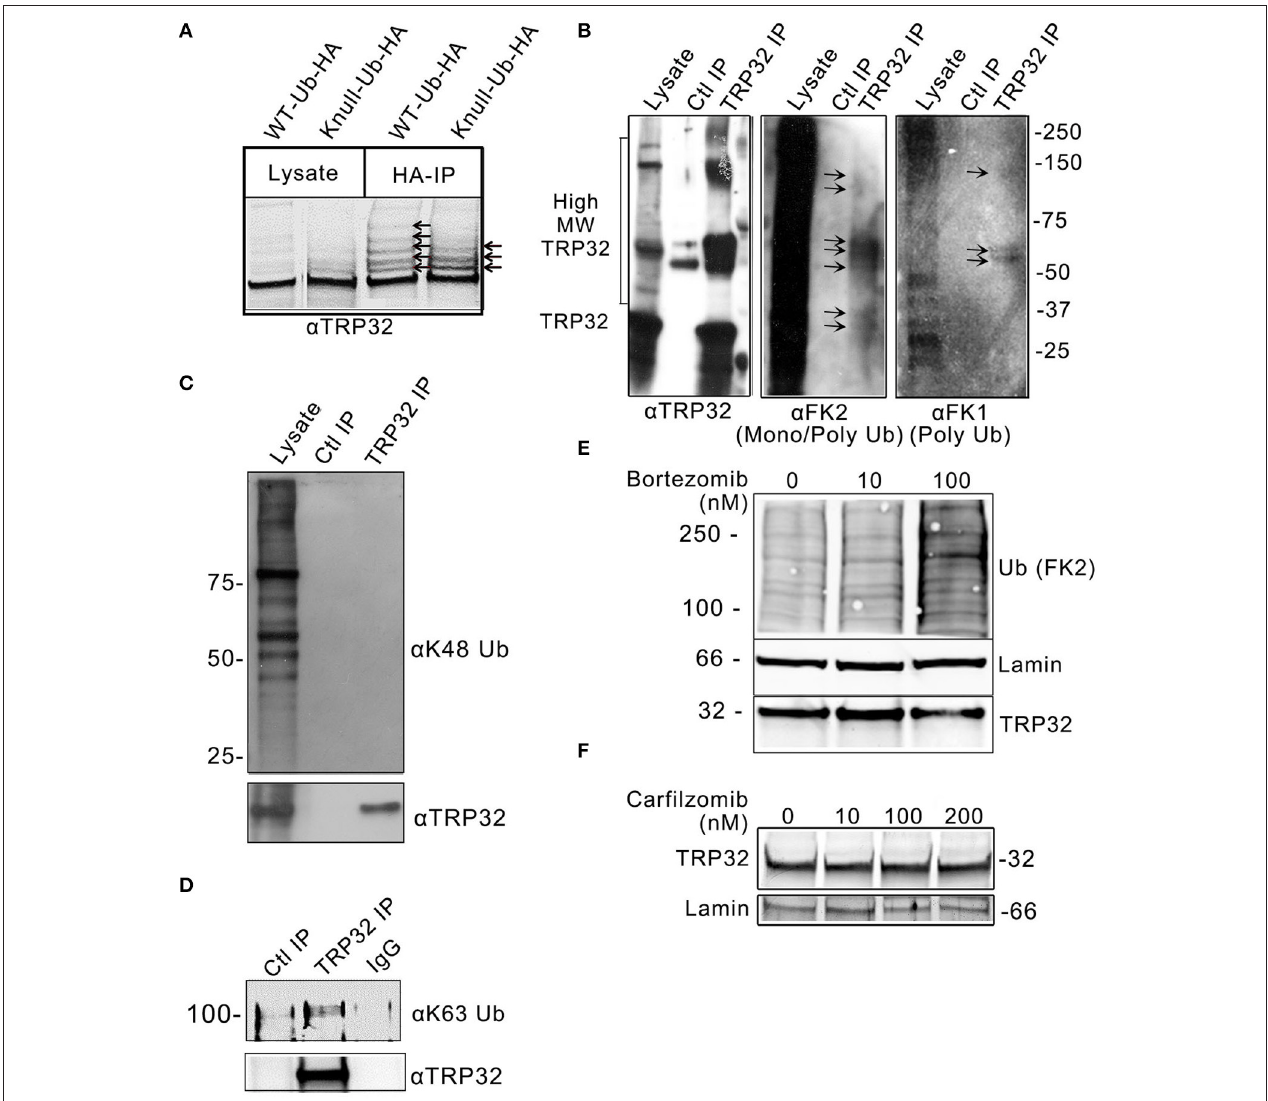
FIGURE 2 | E. chaffeensis TRP32 is mono and polyubiquitinated, but is not degraded by the proteasome. (A) GFP-tagged TRP32 was cotransfected into HeLa cells with HA-tagged WT and K-null Ub constructs. HA-immunoprecipitation was performed and the resulting eluate was probed with anti-TRP32 specific antibody by immunoblot. Multiple higher molecular weight bands indicative of ubiquitinated species of TRP32 were detected (arrows). (B) Multiple species of ubiquitinated TRP32 were also detected during infection of THP-1 cells. Anti-TRP32 specific antibody was used to immunoprecipitate TRP32 from infected THP-1 lysate. The resultant immunoprecipitated protein was probed with antibodies specific for conjugated mono and polyUb chains (FK2) and for polyUb chains alone (FK1) by immunoblot. Bands were detected (arrows) between 25 and 37 kDa, 50 and 75 kDa, and above 100 kDa that colocalized with TRP32 bands. Immunoprecipitation of TRP32 and immunoblot with anti-K48 and anti-K63 Ub antibodies show absence of K48 ubiquitination (C) and presence of K63-linked polyubiquitinated TRP32 (D) . TRP32 levels were unaffected by treatment with a proteasome inhibitor. E. chaffeensis- infected cells were incubated with varying concentrations of the proteasome inhibitor bortezomib (E) for 12h or carfilzomib (F) for 8h prior to harvest and immunoblotting with anti-TRP32 and anti-lamin (ctrl) and anti-Ub (FK2) antibodies.